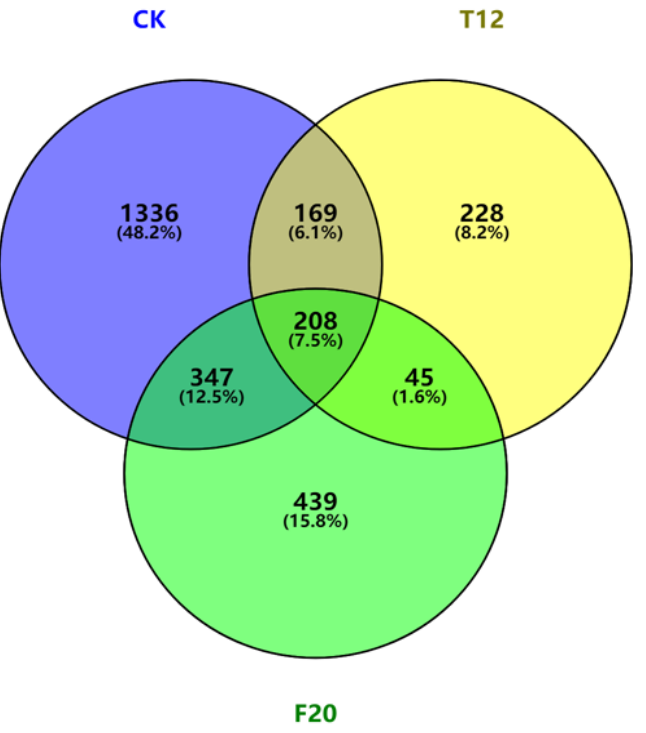
Figure 5. Venn diagram of the DEGs among CK, T12, and F20 under salt stress treatment. CK indicates the DEGs between T01, T02, T03 and T10, T11, T12 samples; T12 indicates the DEGs between T04, T05, T06 and T13, T14, T15 samples; F20 indicates the DEGs between T07, T08, T09 and T16, T17, T18 samples.